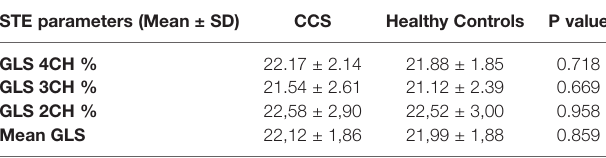
TABLE 4 | Left ventricular strain characteristics measured by 2D speckle- tracking echocardiography among childhood cancer survivors and controls. TABLE 5 | Left ventricular assessment measured by RT-3D echocardiography among childhood cancer survivors and